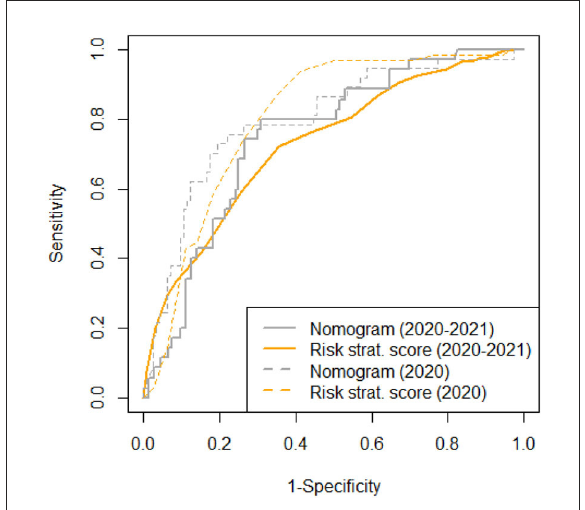
FIGURE2 AUROC for the risk stratification score and the nomogram (8) for all available data sets ( n = 961 and n = 177, respectively) compared to previously published data (